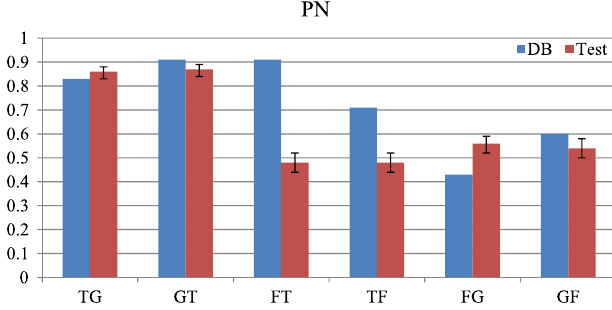
FIG. 10. Comparison of the data from De Bock, Van Dooren, and Verschaffel [15] (DB) and our data (Test) for the PN function type for each of the representational